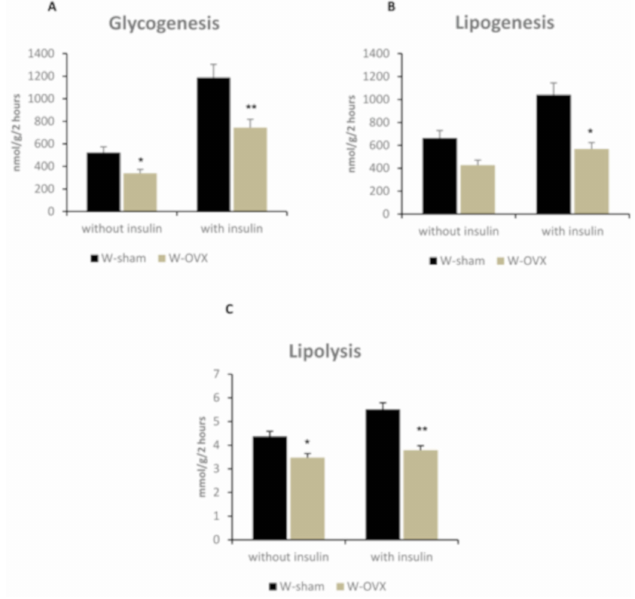
Figure 2. Basal and insulin-stimulated sensitivity in skeletal muscle ( A -glycogenesis) and basal and insulin-stimulated sensitivity in perimetrial adipose tissue ( B -lipogenesis). Basal and adrenaline- stimulated lipolysis from perimetrial adipose tissue ( C ) in ovariectomized Wistar female rats com- pared to sham-operated controls. Significance was determined using the unpaired Student’s t test (* denotes p < 0.05, ** denotes p < 0.01). Table 2. Hepatic parameters of lipid metabolism, transport, oxidative and dicarbonyl stress in